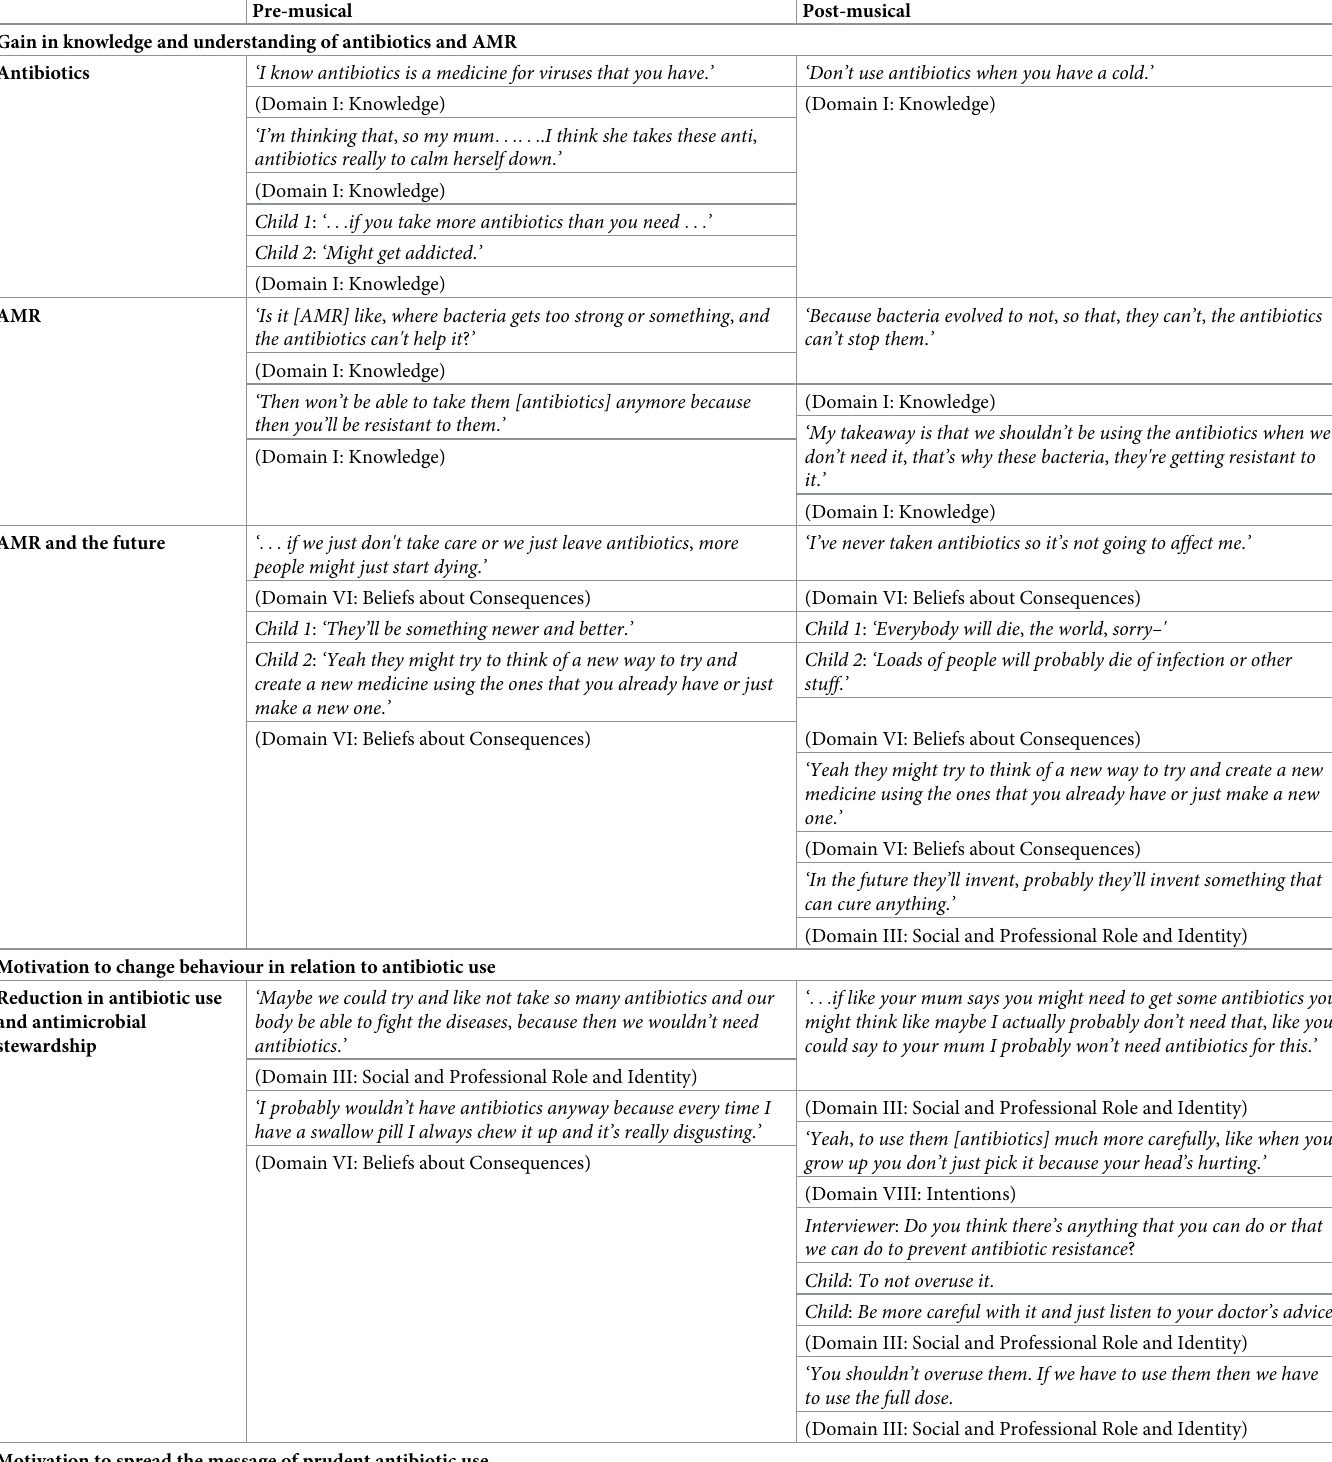
Table 2. Selected focus group (n = 29) responses from participating children pre- and two weeks post-musical, by key emerging theme and mapped to the theoreti- cal domains framework. Pre-musical Post-musical Gain in knowledge and understanding of antibiotics and AMR